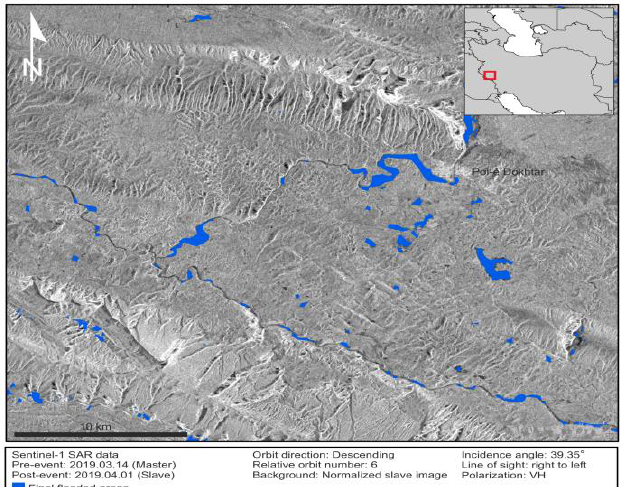
Figure 2. Final flooded areas using sentinel-1 SAR